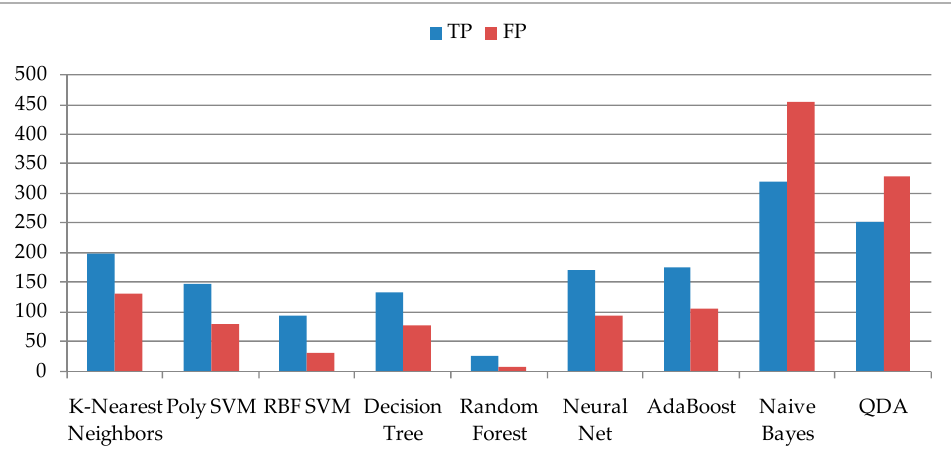
Figure 2. Values for True Positive (TP) and False Positive (FP) after model validation.